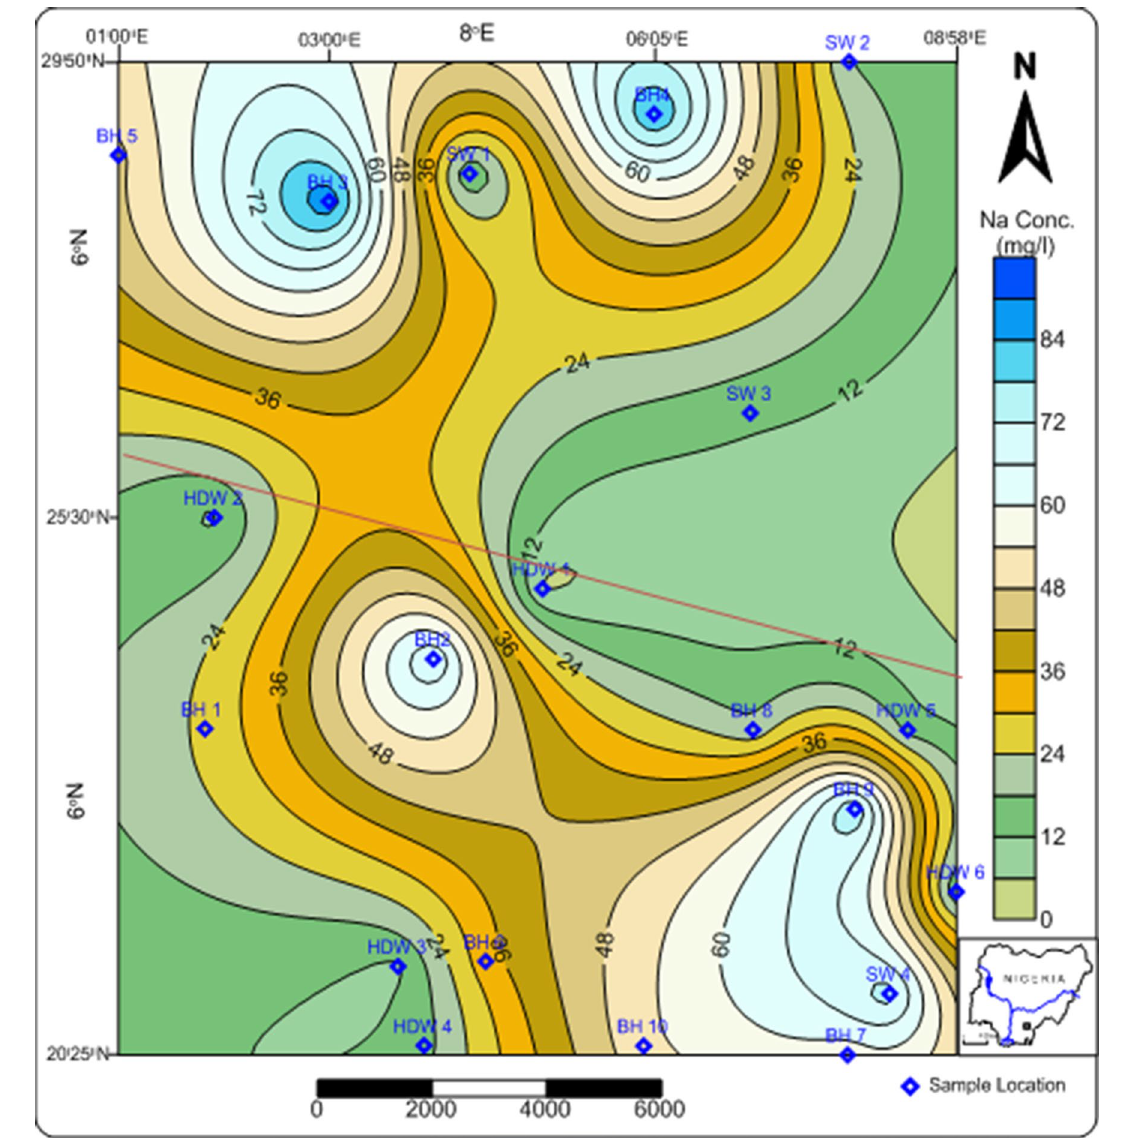
Fig. 22 Map showing the dispersion trend of sodium ion. Note : Perpendicular line indicates groundwater